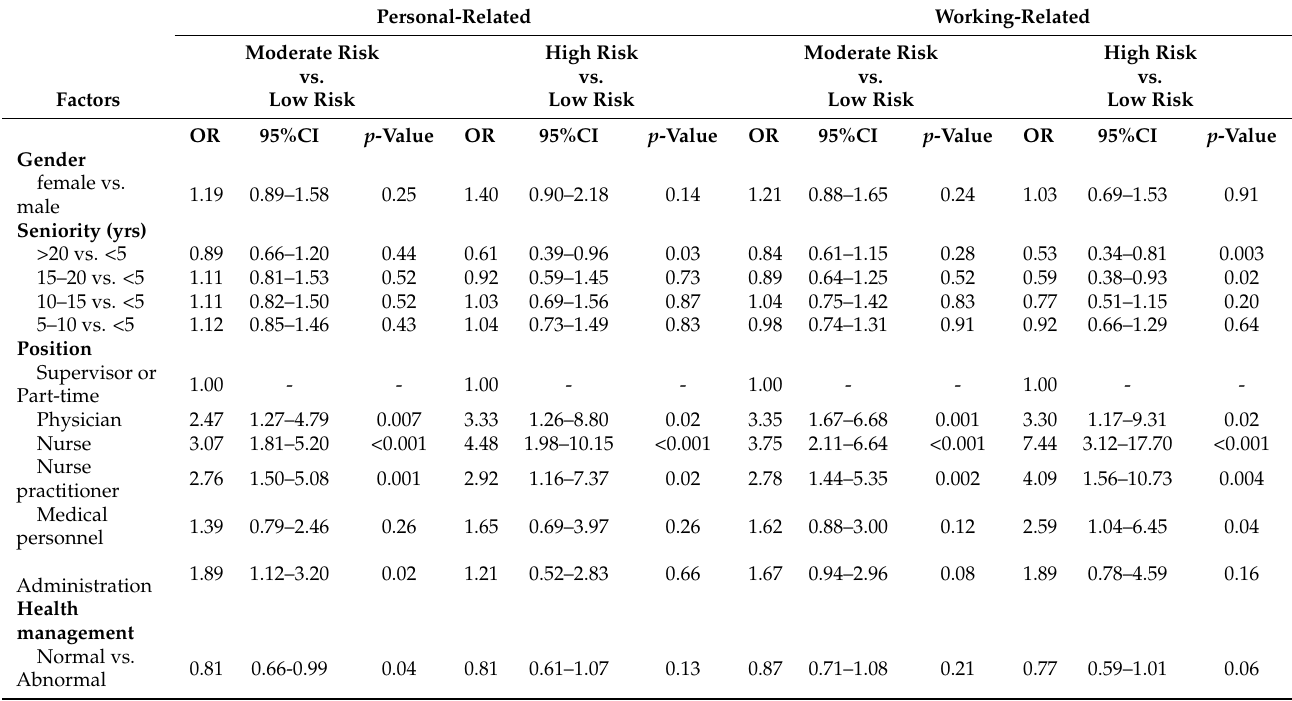
Table 2. Multinominal logistic regression of associated factors for personal-related and working-related fatigue that all univariate significant factors were included among screened subjects ( n =